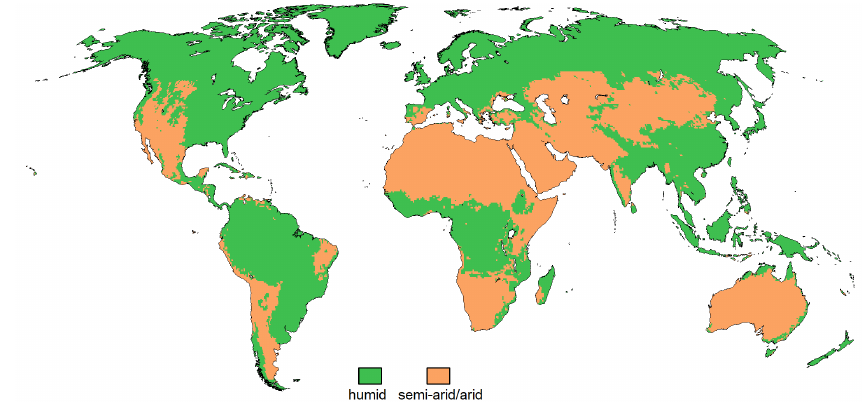
Figure B1. Static definition of humid and semiarid/arid grid